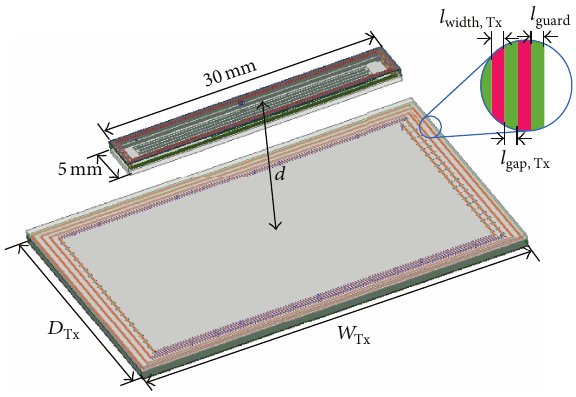
Figure 7: Geometry and comparison of the designed Tx coil and Rx